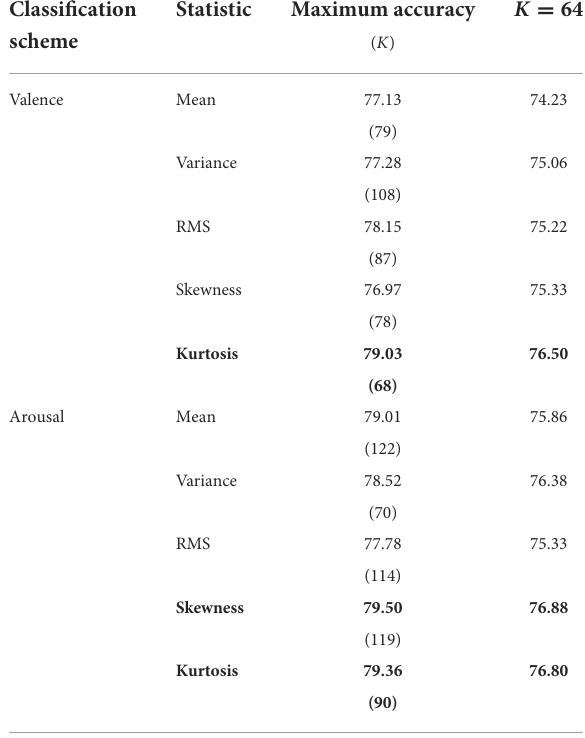
TABLE 6 Comparison of the accuracy (%) of different channel selection methods for the γ